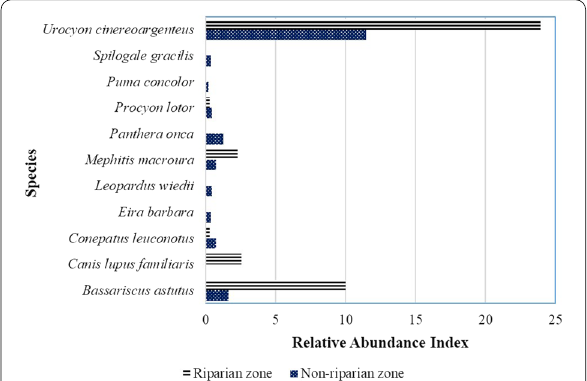
Fig. 4 Relative abundance index of mammalian carnivores in riparian and non‑riparian zones